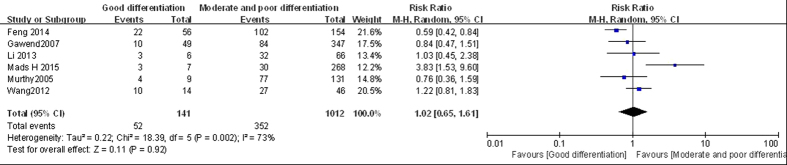
Forest plot of risk ratios of legumain overexpression in well-differentiated vs moderate–poorly differentiated tumor groups.